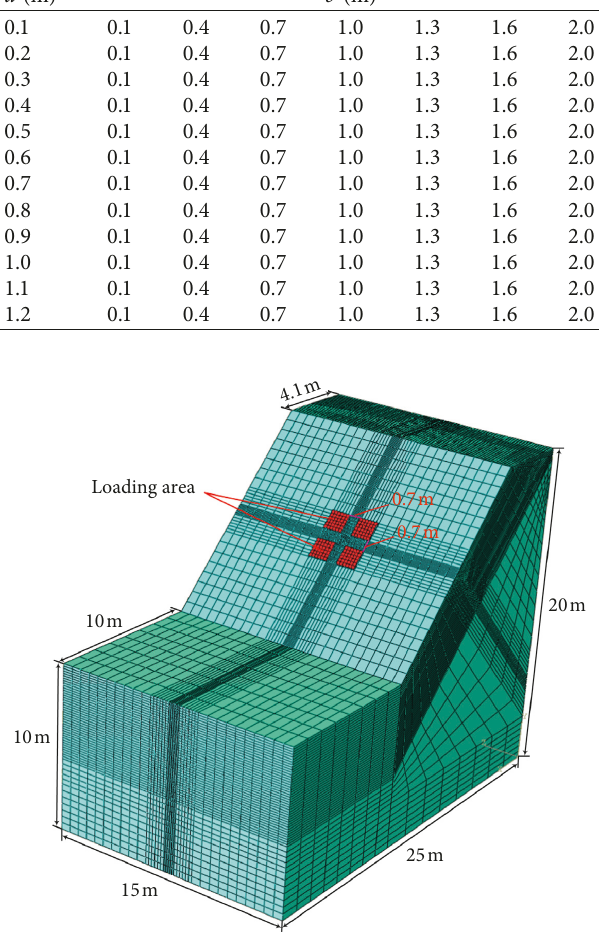
Figure 23: Finite element mesh of a PE with a and b values of 1.0m.